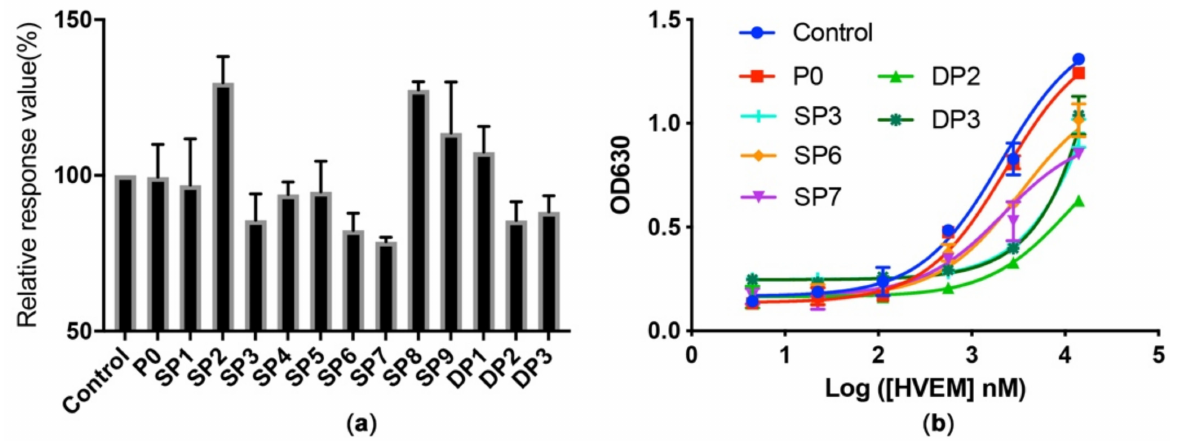
Figure 2. Screen and characterization of predicted peptides. ( a ) Preliminary screen with 1 mg/mL peptides by competitive ELISA. ( b ) Titration of selected peptides-BTLA binding with different concentrations of HVEM.